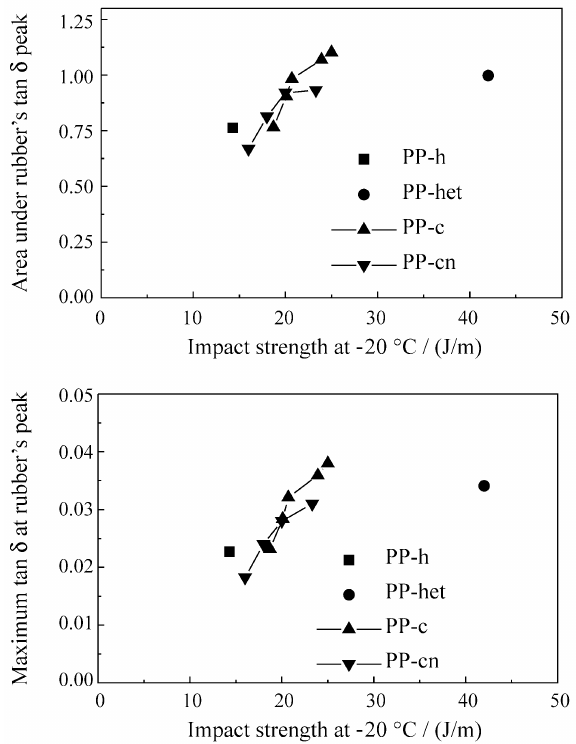
Figure 5. Same as Fig. 4, but measured at -20